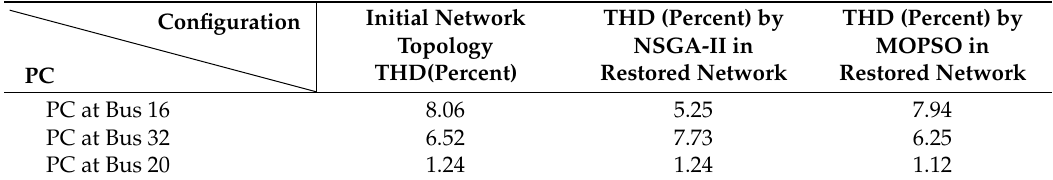
Table 6. Comparison of Total Harmonic Distortion (THD) values.